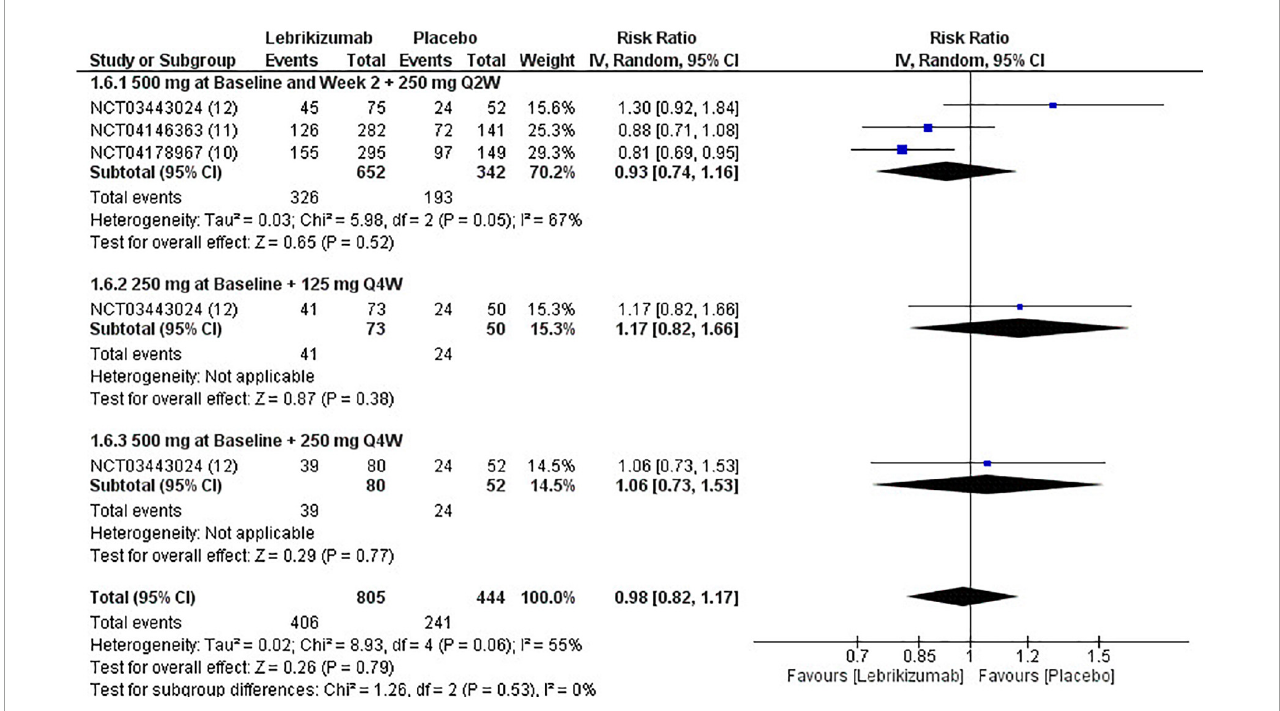
FIGURE10 Forest plot of NSAEs. CI, confidence interval; IV, inverse variance; RR, risk ratio; Q2W, every 2 weeks; Q4W, every 4 weeks.